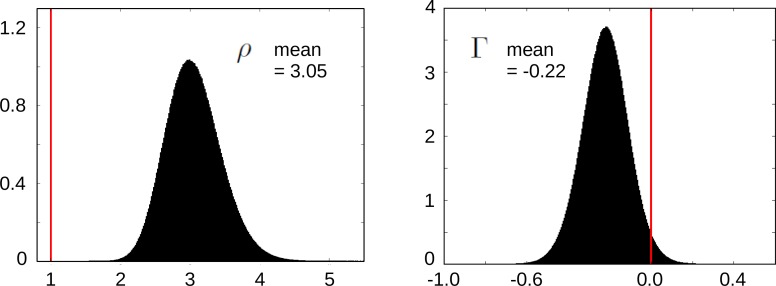
Empirical distributions for ρ (left) and Γ (right).